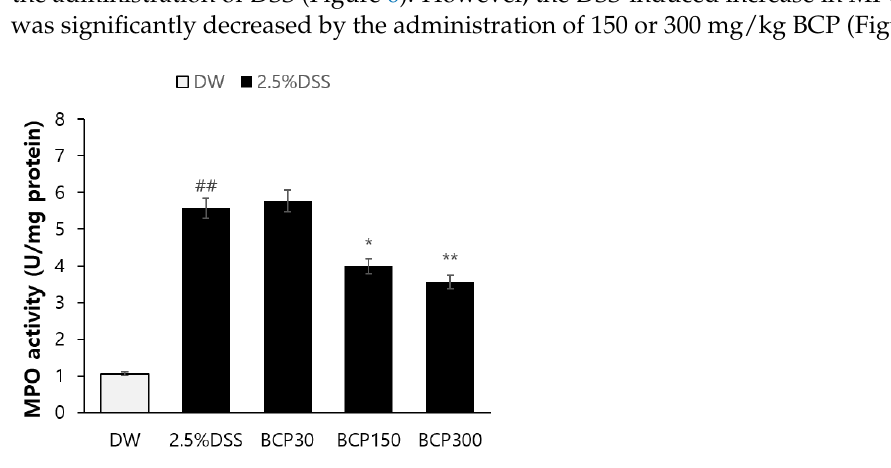
Figure 6. The activity of myeloperoxidase (MPO) in mouse colons. MPO activity in the colon was measured as an immunological parameter for acute inflammation. Data are presented as mean ± SEM. Group comparisons were performed using unpaired t-test with post-test (##, p < 0.01, compared to vehicle-treated control mouse) (*, p < 0.05; **, p < 0.01, compared to vehicle-treated, DSS-induced colitis mouse).